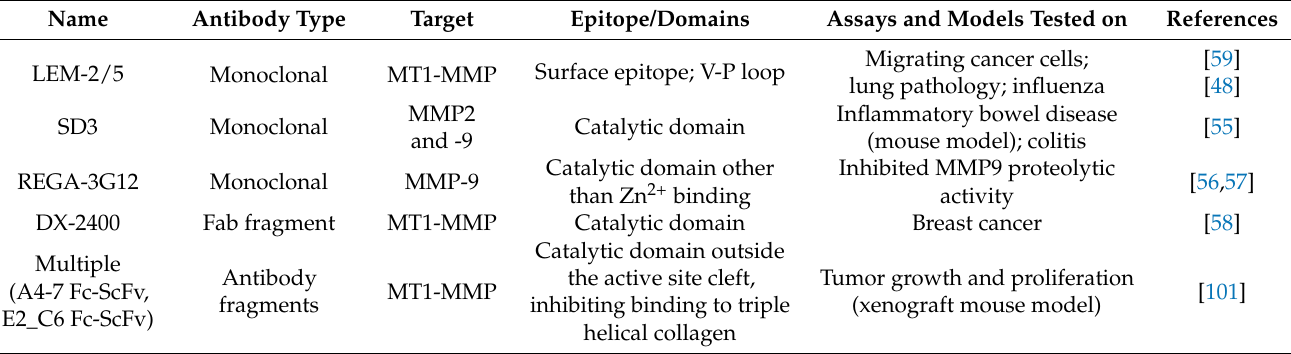
Table 3. Regulation of MMP inhibition by